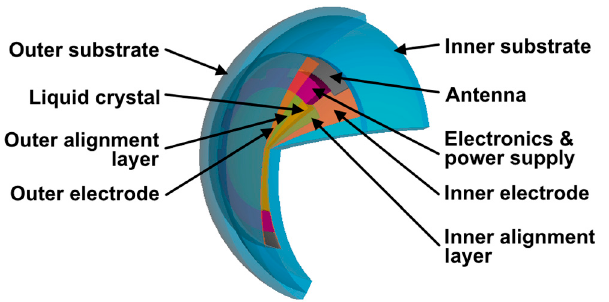
Figure 14. Illustration of the basic design principles for an LC contact lens. The LC is encapsulated between two substrate lenses. Both of the substrates are coated with electrode and alignment layers on their inner surfaces. The electronics (processor, power supply and antenna) are kept out of the central region of the lens so they do not block the wearer’s vision.